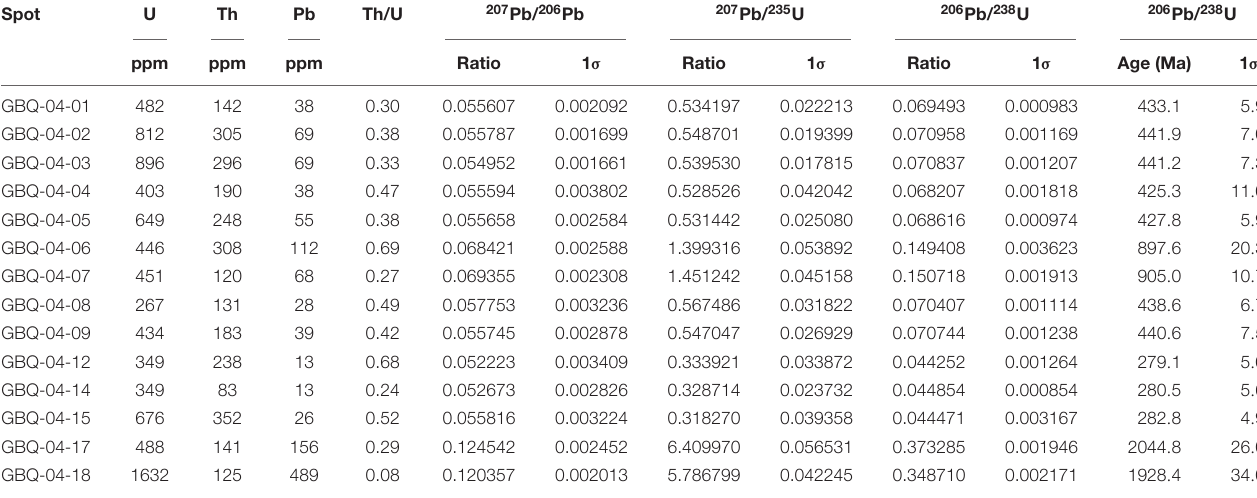
TABLE 1 | Concentrations of U, Th, Pb, and U-Pb isotopes of zircon crystals from a large (25 kg) dolerite sample from the Gubaoquan dolerite